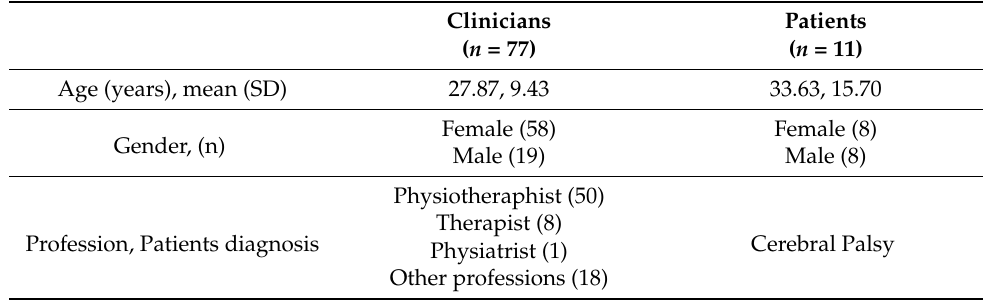
Table 1. Participants Demographic